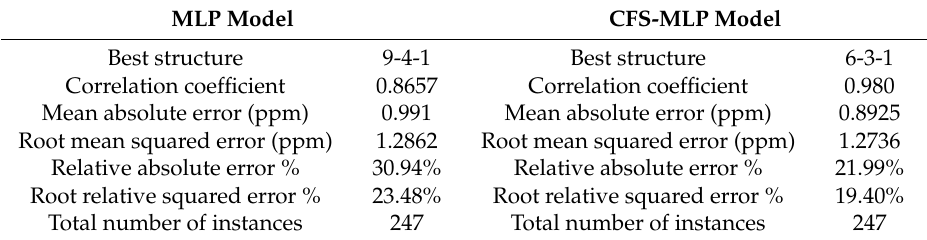
Table 5. Results of predictions with MLP model and the proposed model (CFS-MLP)